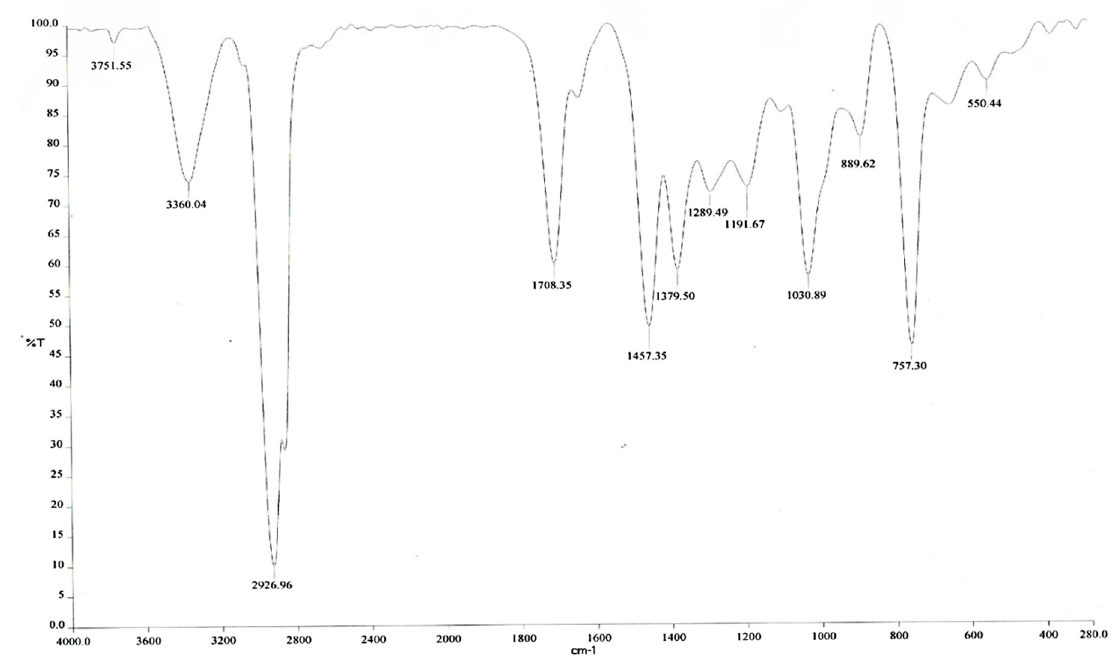
Figure 5. The FT-IR spectrum of the optimized red pitaya peel extract.